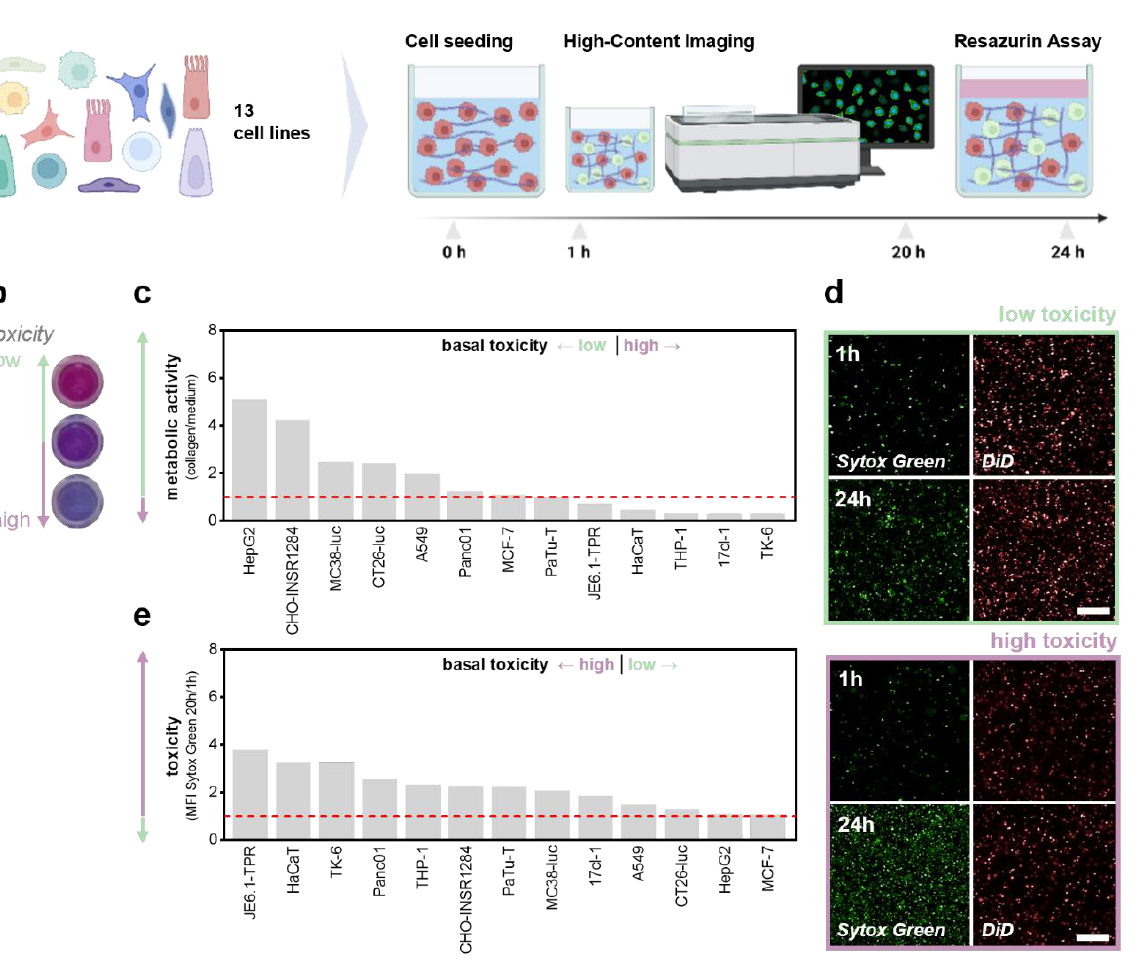
Figure 3. Thirteen cell-line screening to compare basal toxicity levels in 3D collagen hydrogels. ( a ) Schematic overview of the cell line screening; ( b ) representative images of the resazurin assay; ( c ) metabolic activity of cells grown in collagen hydrogel cultures normalized on medium controls; ( d ) representative images of sytox green and DiD labeled cells 1 h and 20 h after incubation; ( e ) sytox green fluorescence intensity after 20 h incubation normalized for 1 h. The bar graphs show the mean. Scale bar = 250 µ m. MFI = mean fluorescence